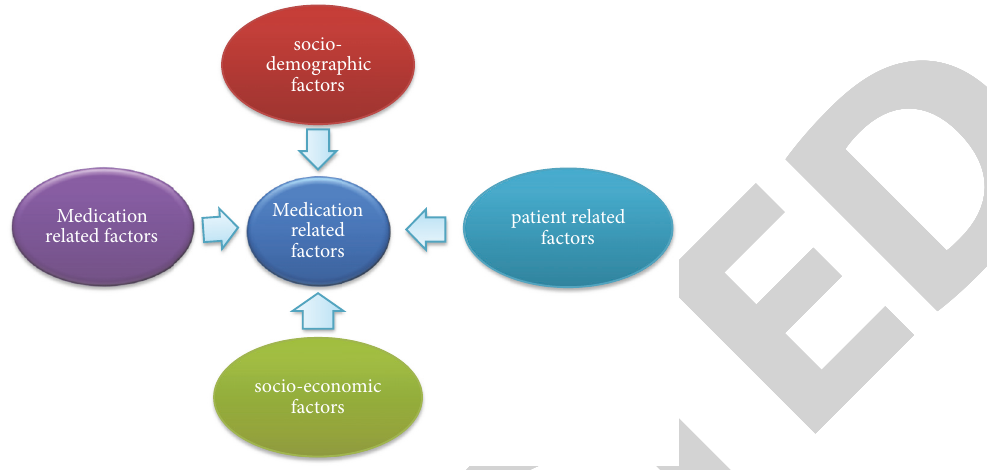
Figure 1: Structural framework for factors affecting medication